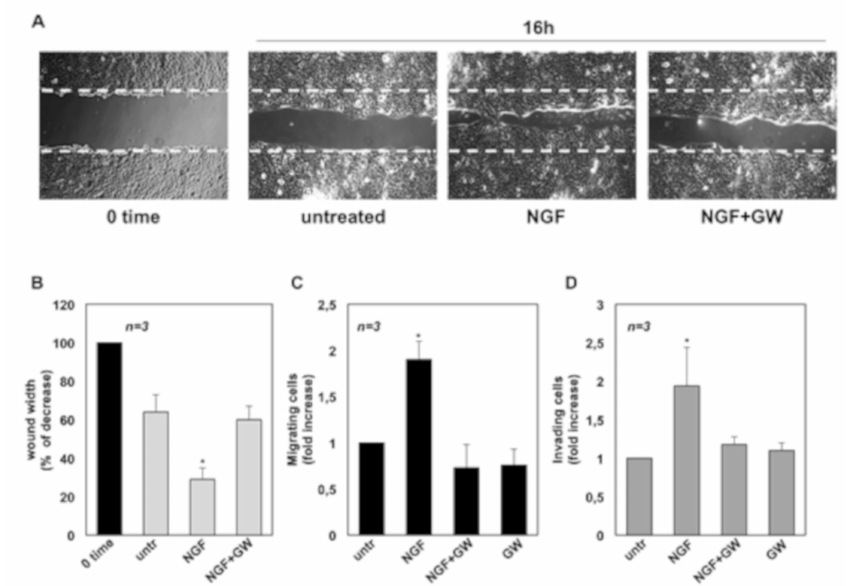
Figure 3. Nerve growth factor (NGF) triggers migration and invasiveness in DU145 cells. In A , quiescent DU145 cells were wounded and then left untreated or treated with NGF for the indicated